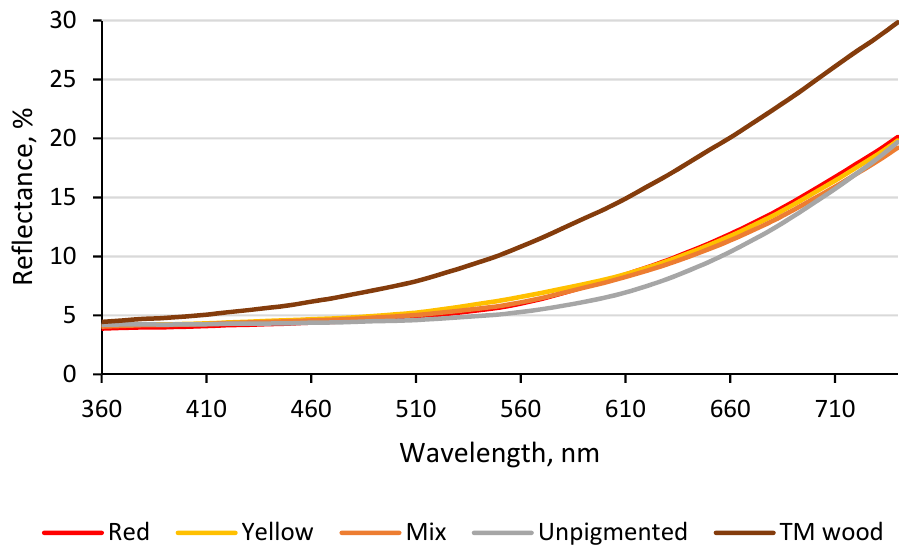
Figure 5. Reflectance spectra of uncoated thermally modified (TM) wood and thermally modified wood coated with unpigmented and with yellow, red, and a mixture (mix) of red and yellow (1:1) iron oxides pigmented transparent coatings.